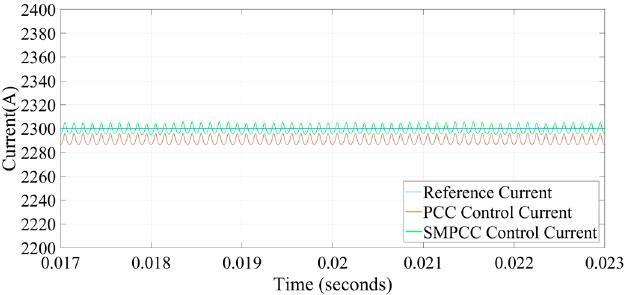
Figure 3. The simulation analysis of steady-state current.